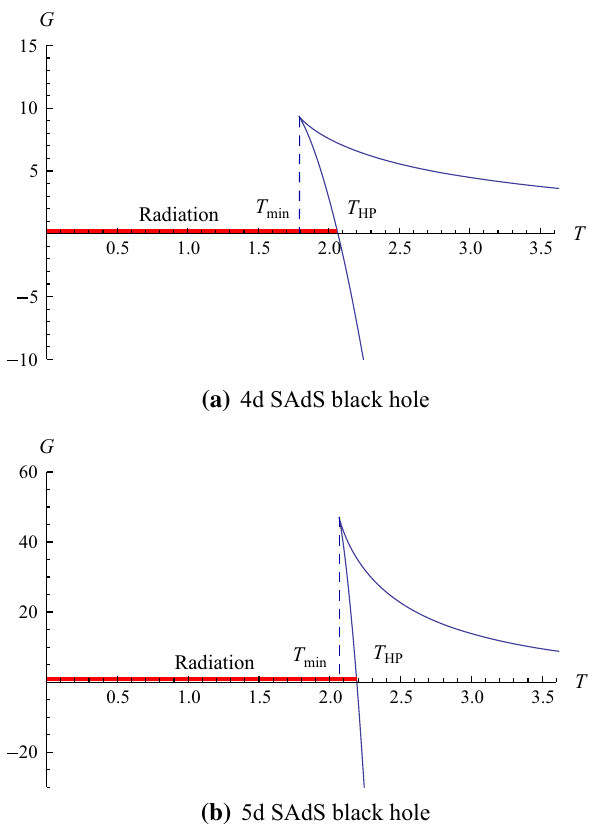
Fig. 6 The G − T diagrams of four- and five-dimensional Schwarzschild AdS black holes for P = 0 . 2 and k = 1. The radiation phase is displayed by a horizontal magenta line . The Hawking–Page phase transition between thermal radiation and black holes occurs at T = T HP . For T > T HP , this branch has a negative Gibbs free energy and the corresponding black holes represent the globally thermodynamically preferred